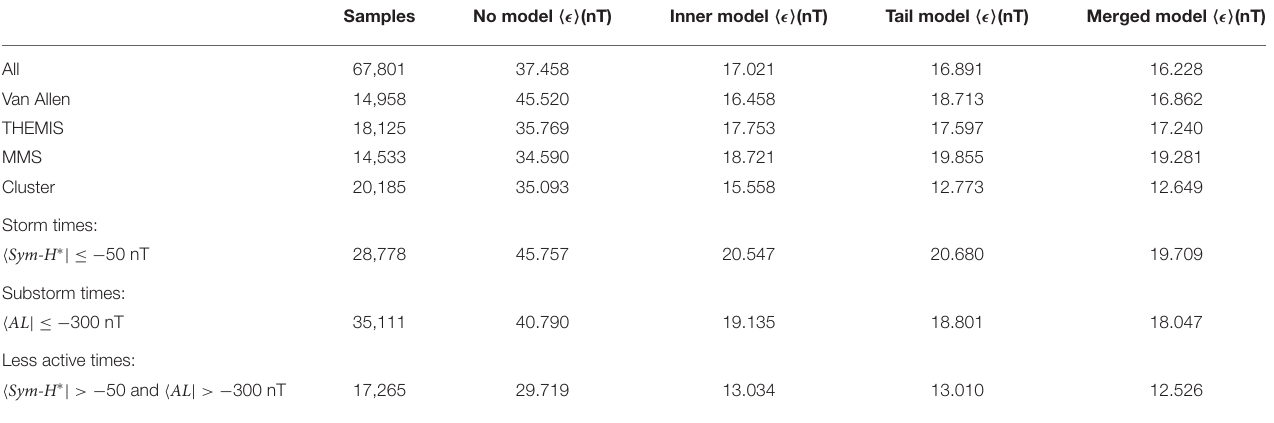
TABLE 1 | Out-of-sample model errors